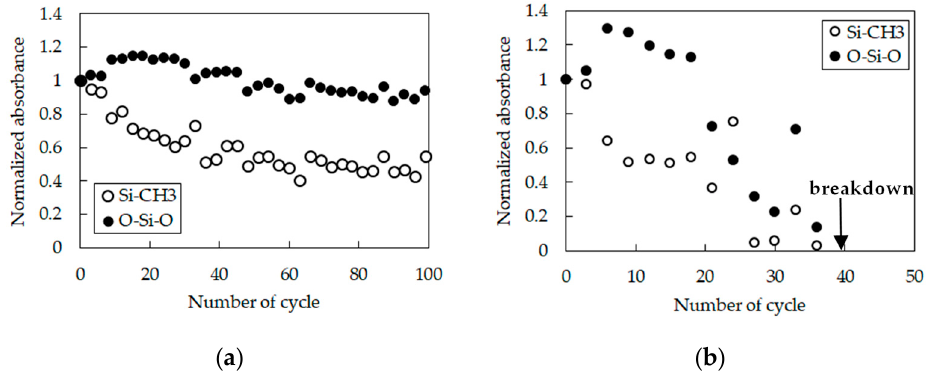
Figure 12. Change in normalized absorption of Si-CH 3 and O-Si-O with the number of cycle obtained in the 100-cycle test with 2 mm air gap. ( a ) Sample A; ( b ) Sample